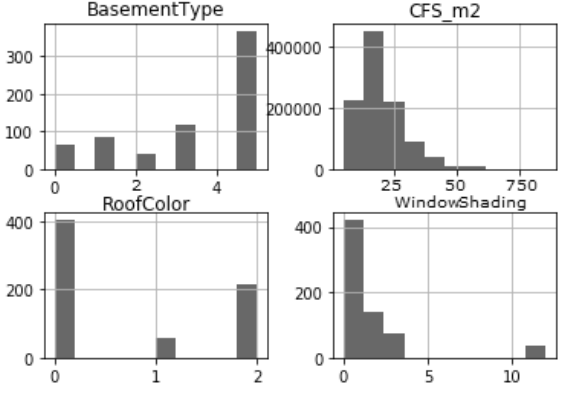
Figure 4. Histogram representation of some parameters for the first approach.